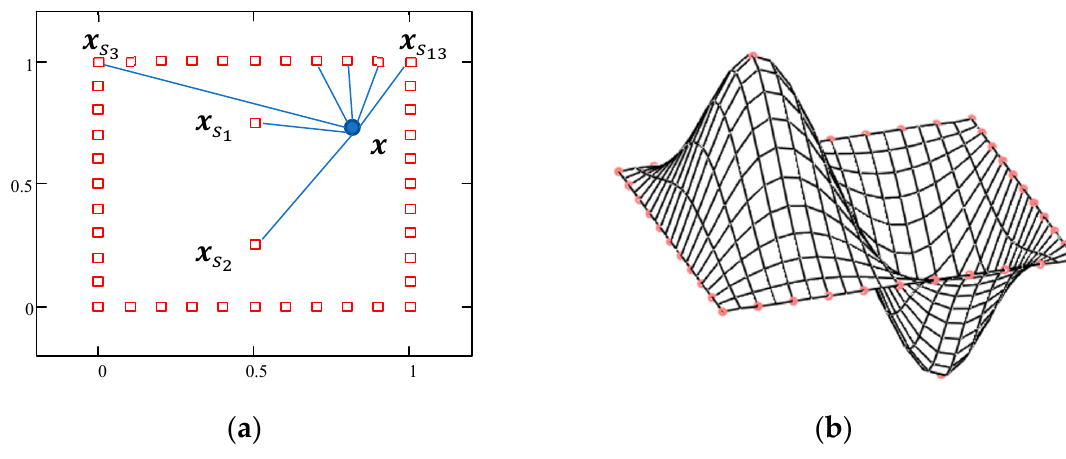
Figure 1. RBF interactions between source points ( a ) and surrounding volume ( b ).